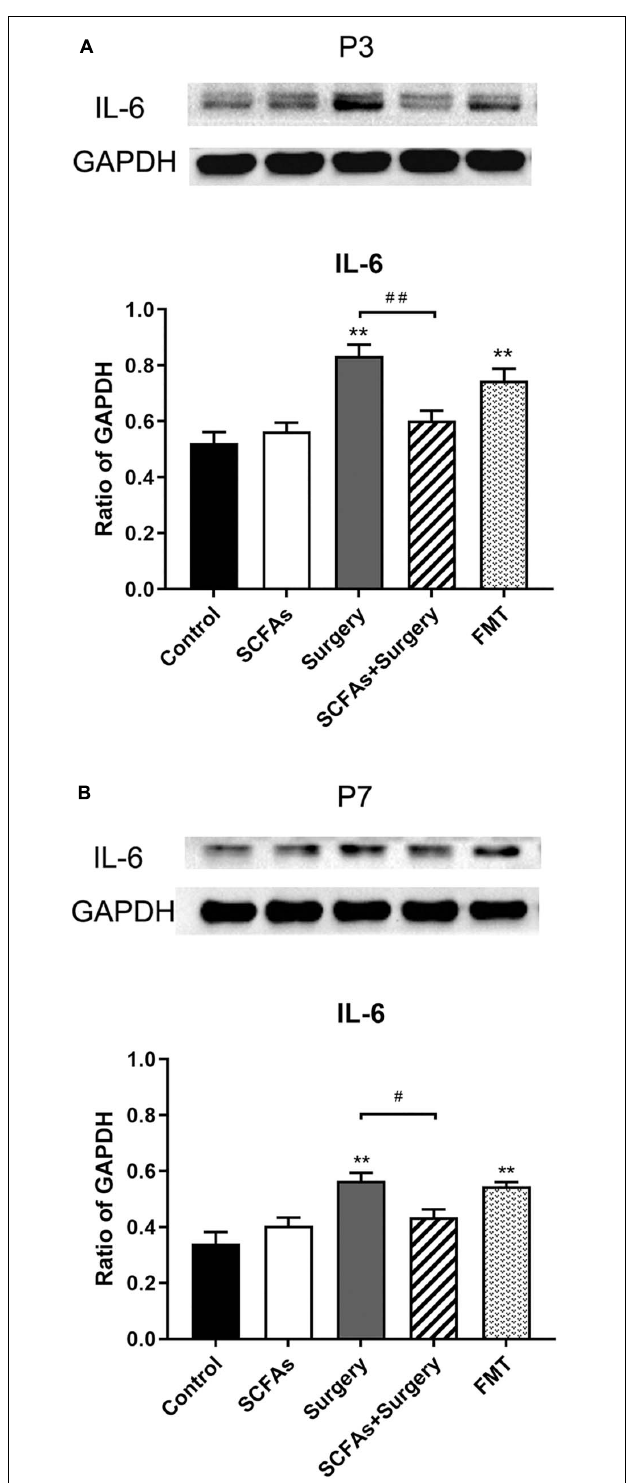
FIGURE 5 | Surgical trauma and anesthesia and fecal microbiota transplantation significantly enhanced hippocampal IL-6 expression on postoperative or post-transplantation day 3 compared with the control group. Pretreatment with SCFAs partially reversed the higher expression of IL-6.